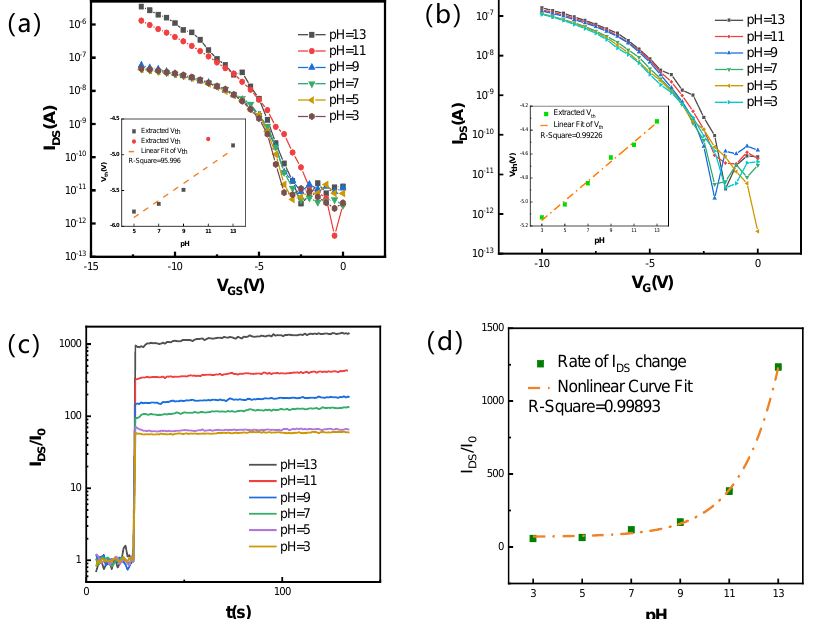
Figure 7. ( a , b ) Transfer characteristic curve (I DS -V G ) at different pH liquid gate environments (3–13) of SiNW FET and hydrogel-functionalized SiNW FET after four weeks, respectively, and the insets are extracted threshold voltage under different pH time-response curves. ( c ) Real-time response curve of I DS as a function of time for hydrogel-functionalized SiNW FET in different pH solutions after four weeks, and ( d ) current rate of change under different pH time-response curves of hydrogel- functionalized SiNW FET.